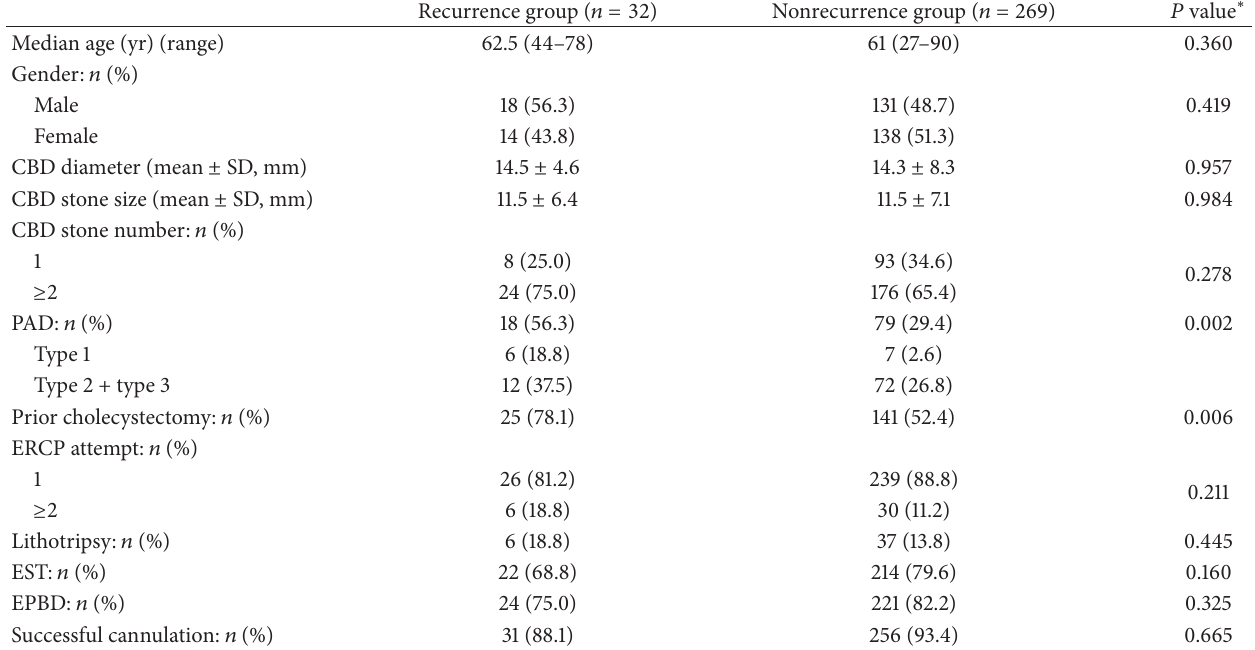
Table 3: Univariate analysis of the risk factors for recurrence of symptomatic CBD stones. Recurrence group ( 𝑛 = 32 ) Nonrecurrence group ( 𝑛 = 269